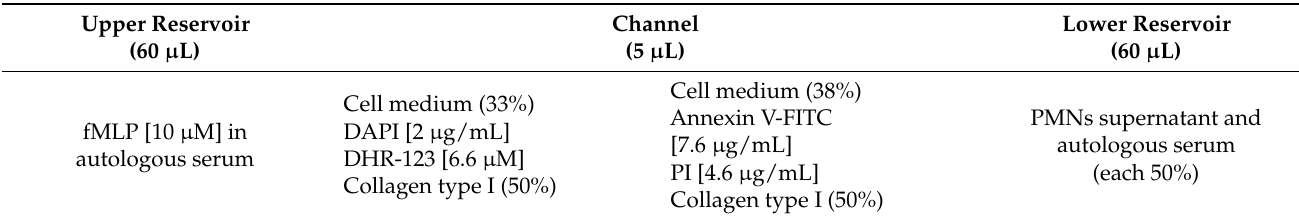
Table 7. Composition of a channel and its reservoir fillings of the µ -Slides VI 0.1 used.